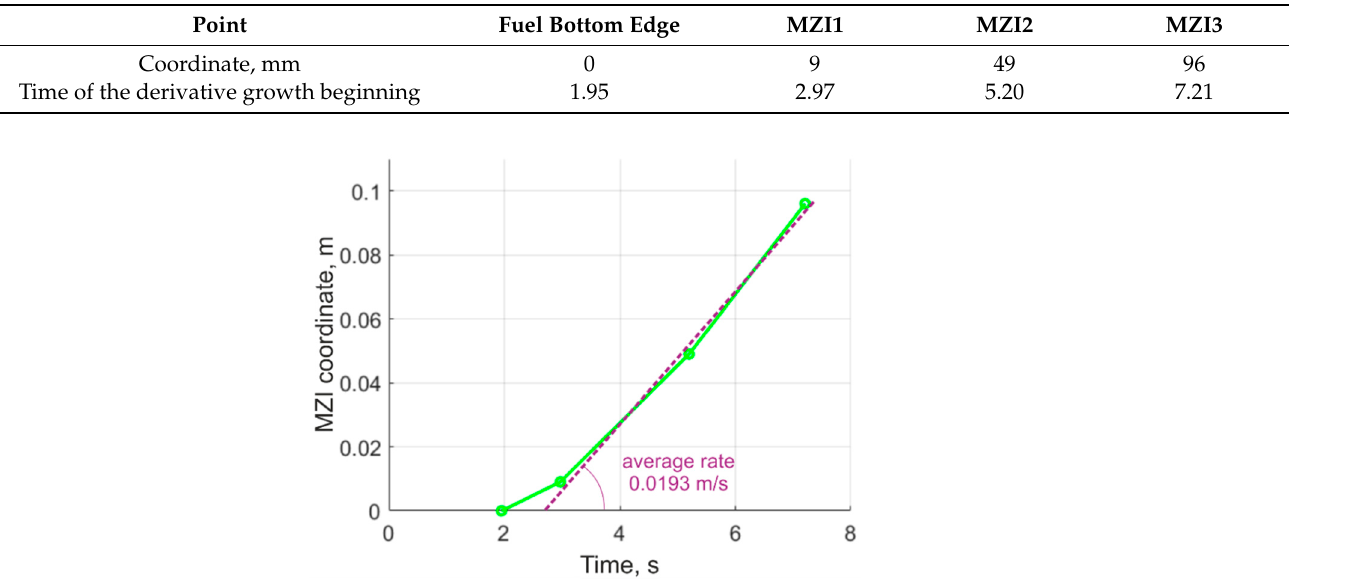
Figure 9. Derivative plots of increasing diameter.